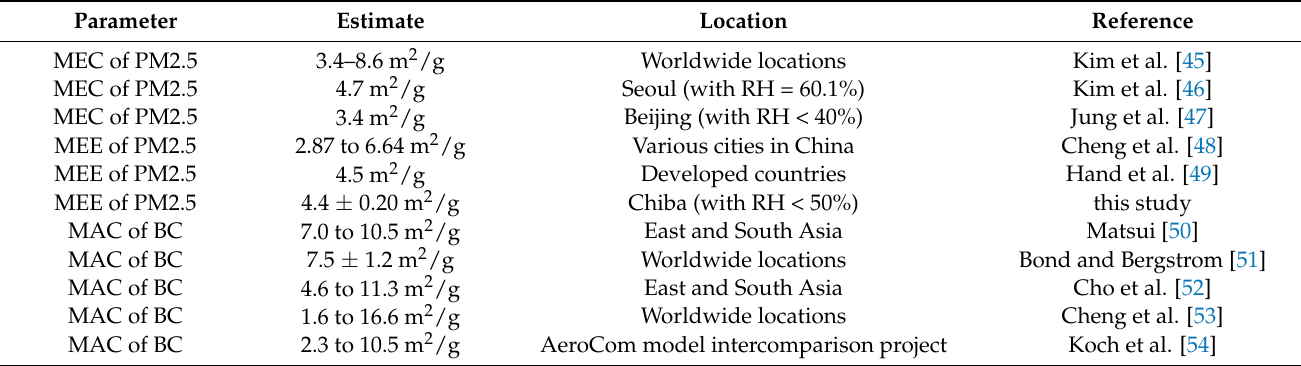
Table 2. Estimate of the mass extinction coefficient (MEC) and mass extinction efficiency (MEE) of PM2.5 particles and mass absorption coefficient (MAC) of BC obtained by various techniques, under different conditions, at various locations. Parameter Estimate Location MEC of PM2.5 3.4–8.6 m 2